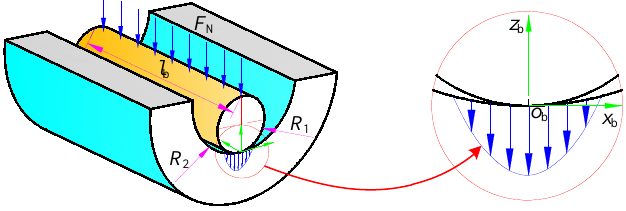
Figure 5. Hertz contact model of the guide pad and the hole wall.